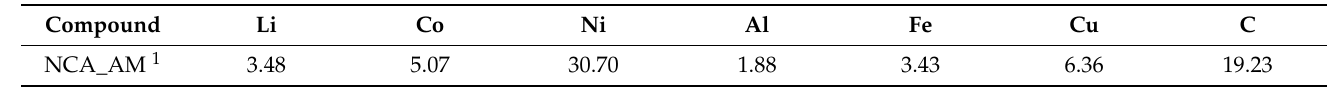
Table 5. ICP-OES analysis of relevant elements in the sample after flotation for use in downstream InduMelt experiment in wt.-%.